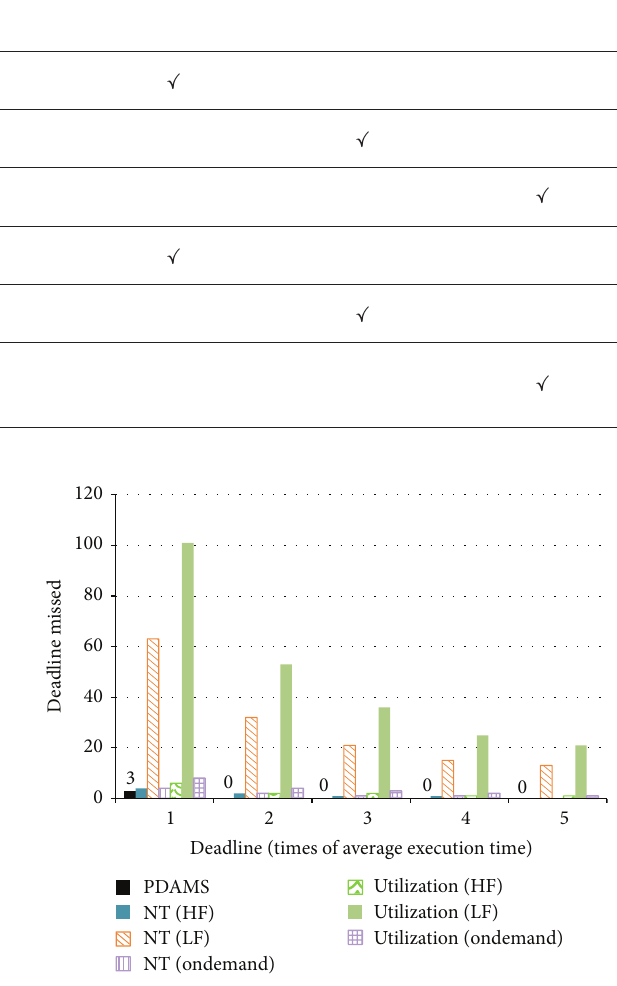
Figure 10: Comparison of